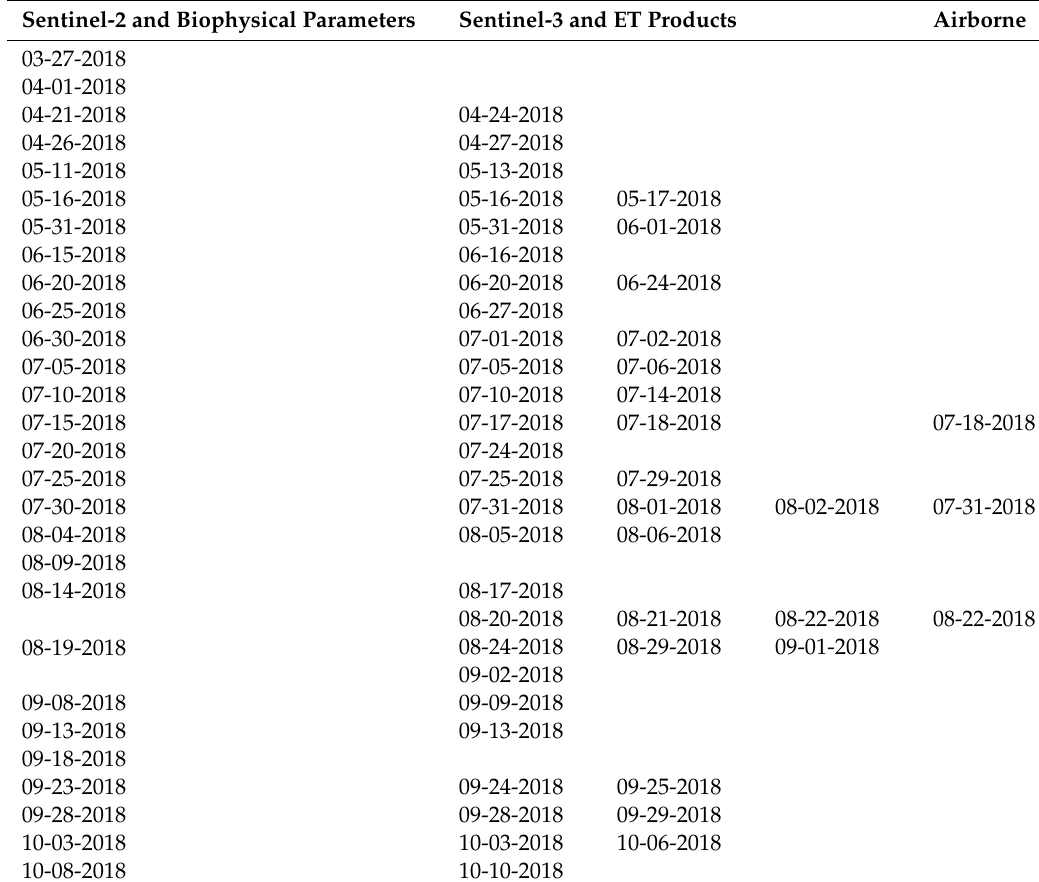
Table 1. Acquisition dates of the Sentinel 2 and Sentinel-3 cloud-free images used in the analysis (Sentinel 2: tile 31TBG, Sentinel 3: 6059) and airborne thermal imagery. For each Sentinel 2 acquisition, there is generally one or more Sentinel 3 acquisitions, with a maximum delay of 4 days relative to the Sentinel-2 acquisition